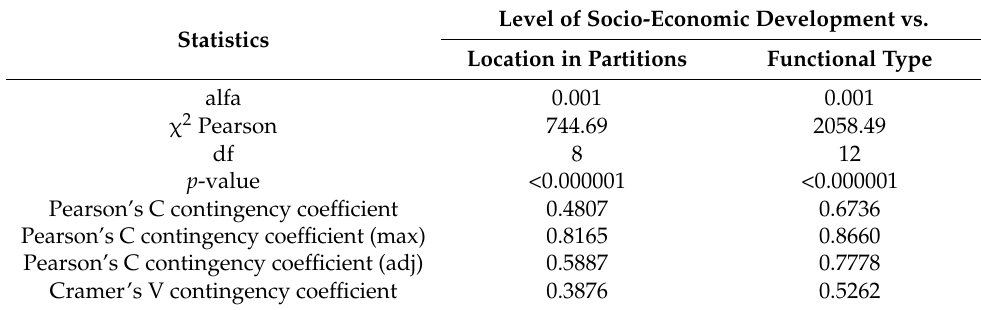
Table 3. Test results of the relationship between the level of socio-economic development and the location within the borders of the former partitions and the functional type. Source: own